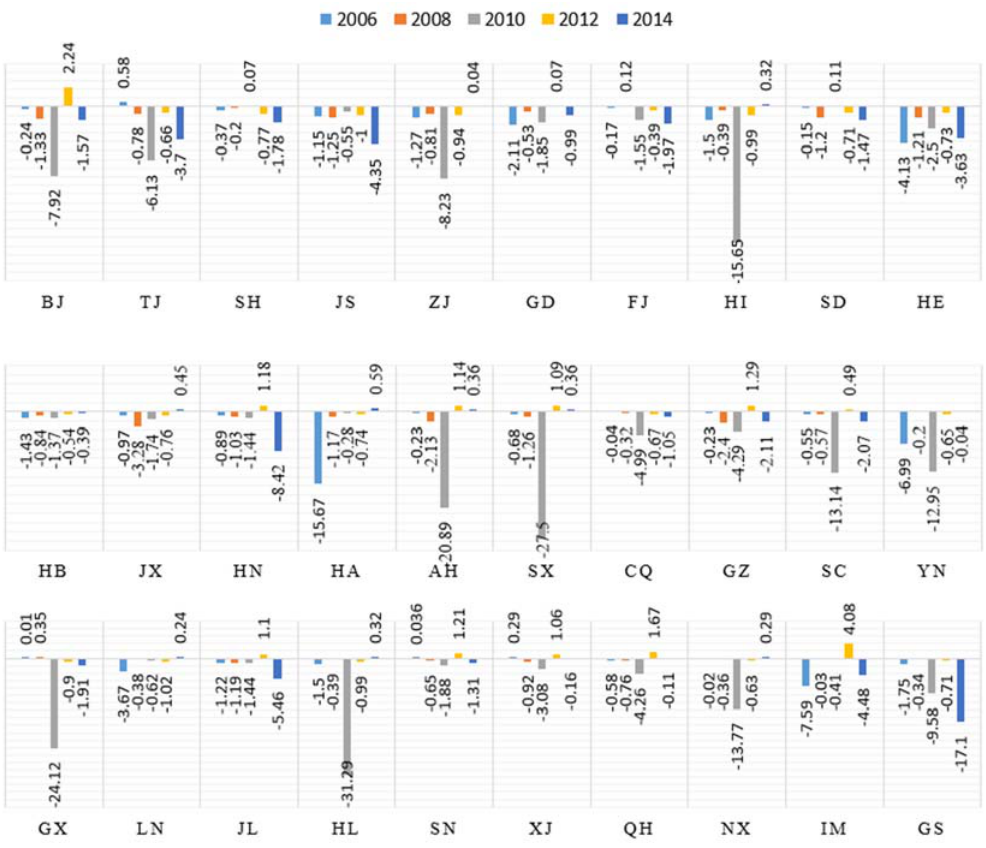
Figure 5. Contributions of indirect carbon intensity of 30 provinces in 2006, 2008, 2010, 2012 and 2014.